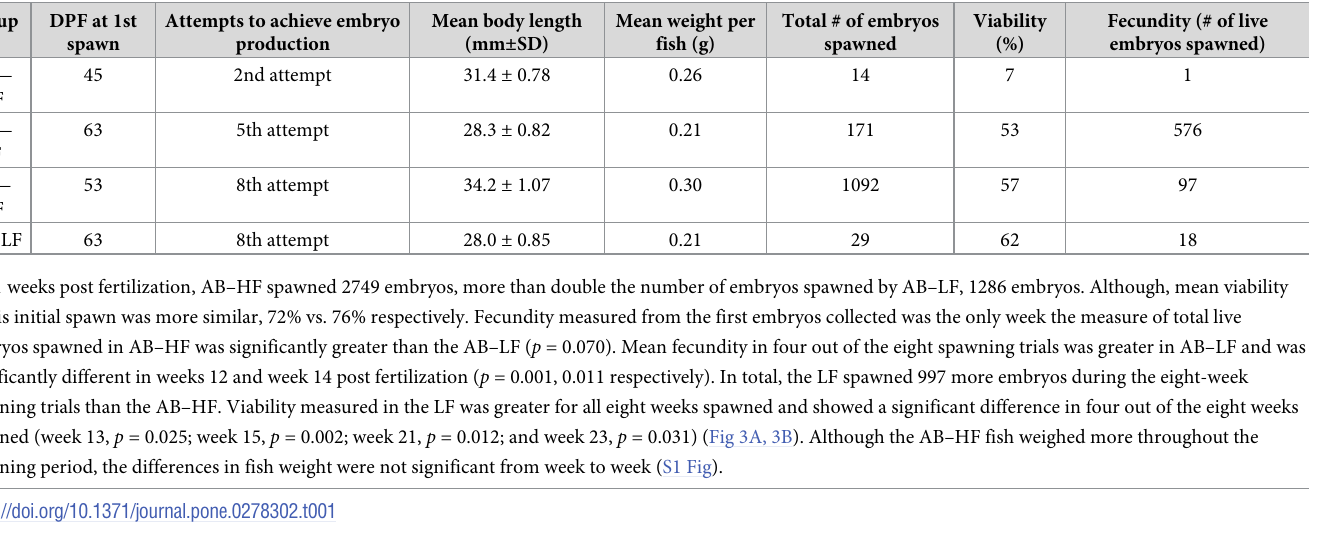
of the 15 F females from the HF in both strains exhibited distended abdomens suggesting pos- 0 sible egg-associated inflammation [36]. In fact, females in the HF weighed 30% more in AB and 45% more in Tu¨ than females in the LF from either group. Attempts to pair-wise spawn F fish resulted in higher spawning success, greater fecundity, and improved viability in the LF.